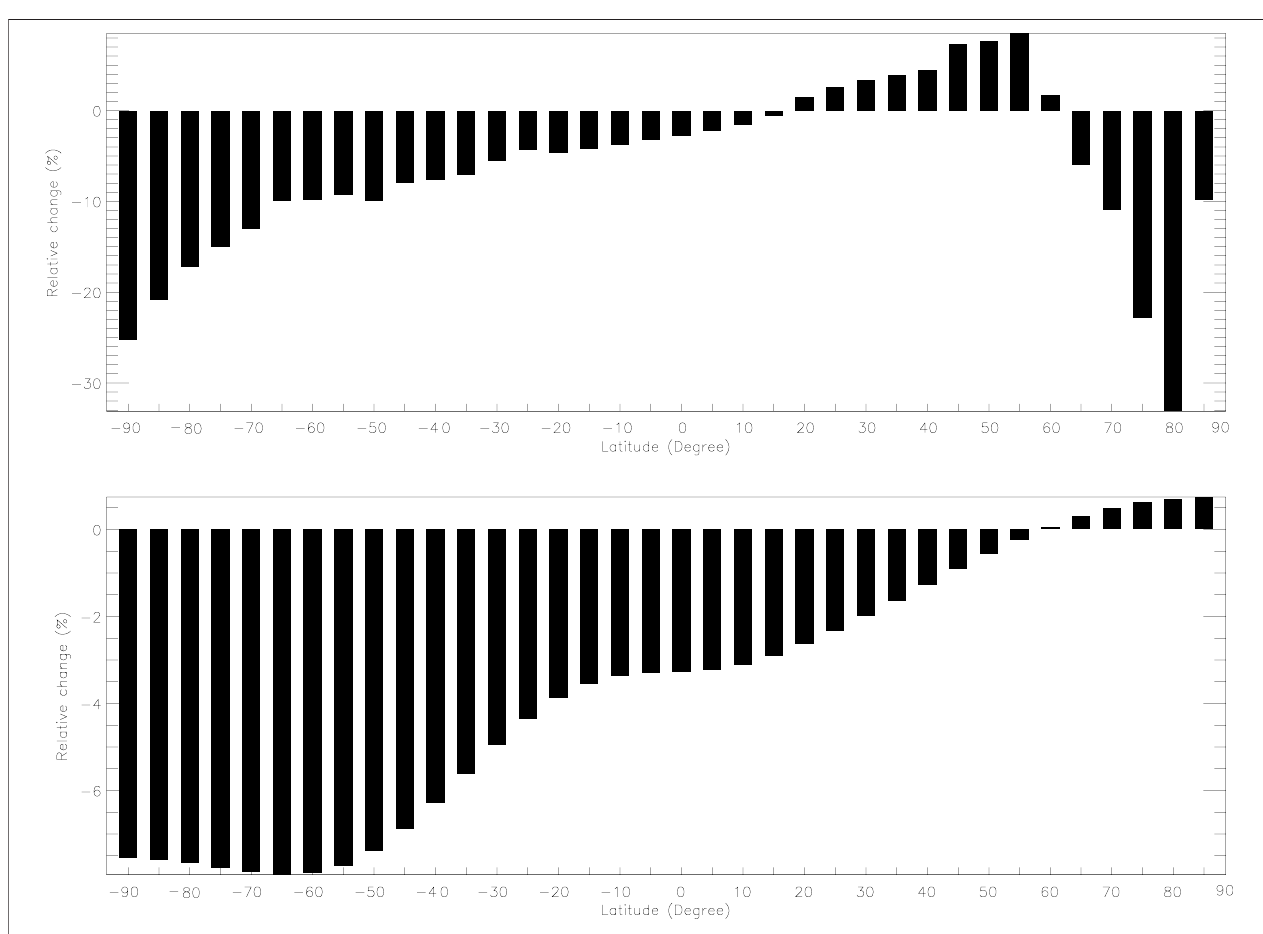
FIGURE 7 | Histogram of variation of background geomagnetic fi eld and cutoff rigidities with the latitude between 1965 and 2025. The upper panel indicates that the relative change of magnetic fi eld changes with the latitude, and the lower panel indicates the relationship between the relative change of cutoff rigidities and latitude.